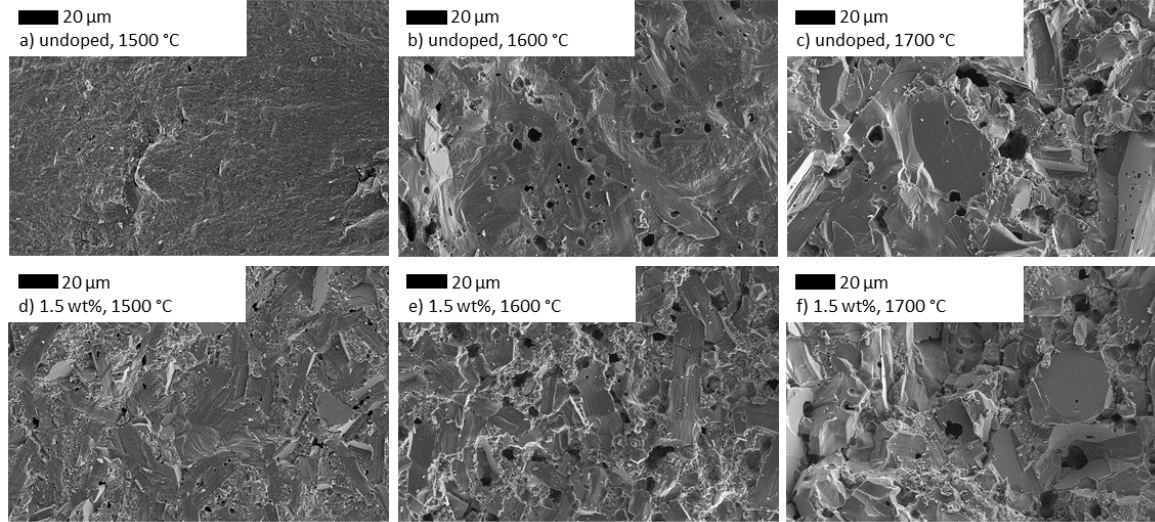
Figure 7. SEM images of Na- β″ -alumina samples sintered at 1500 °C, 1600 °C, or 1700 °C; ( a – c ) undoped samples; ( d – f ) Na- β″ -alumina doped with 1.5 wt% TiO 2 . Images ( a ), ( b ), ( d ), and ( e ) were rearranged and reprinted with permission from Dirksen et al. [13].